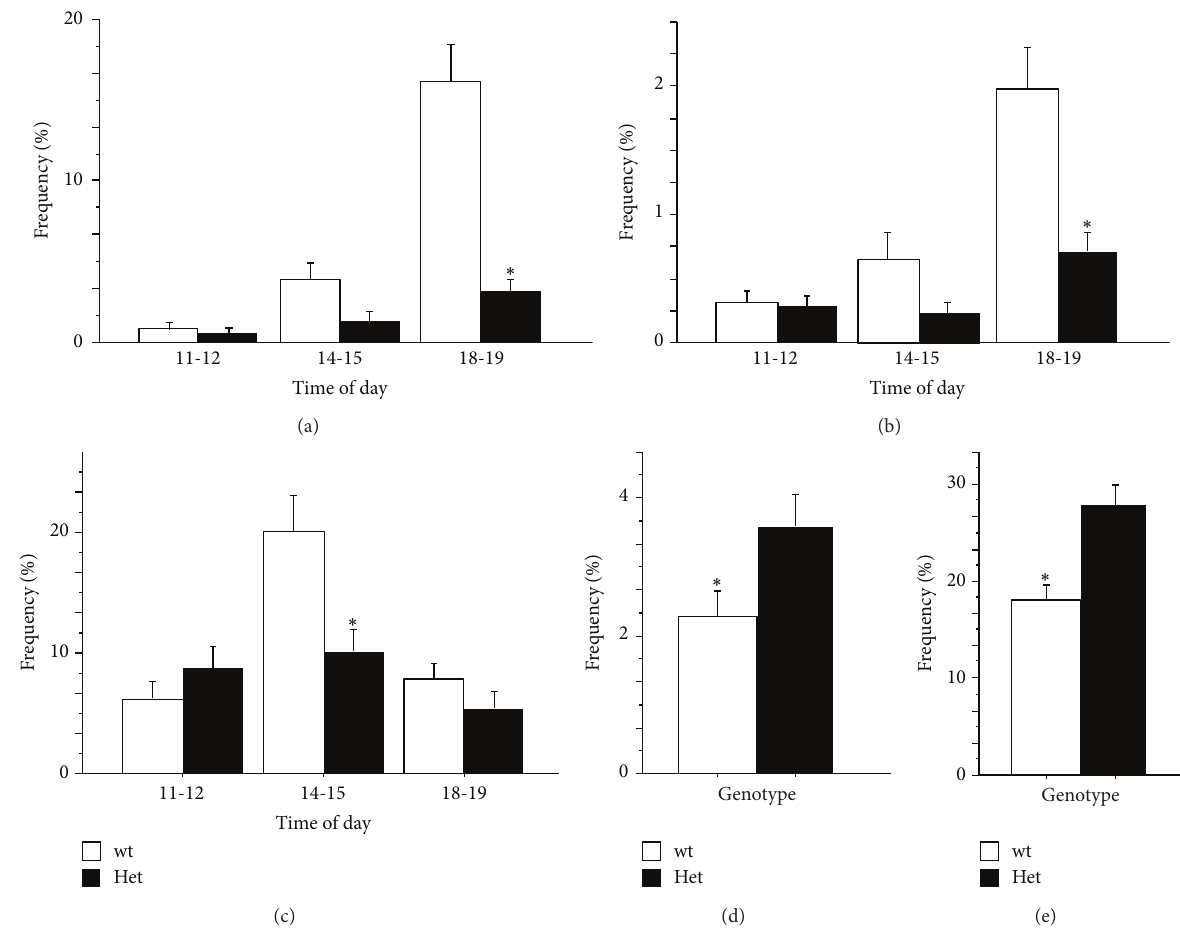
Figure 3: Spontaneous behavioural profile in the home-cages. The analysis of spontaneous behaviour in the home-cages revealed that MeCP2- 308 heterozygous female mice (Het) show decreased cage-directed exploratory behaviours in the home-cages compared to wild-type controls (wt). Burrowing (a) and digging (b) and bar holding episodes (c) were significantly less frequent in Het mice. Het mice spent more time drinking (d) and eating (e) compared to wt. The spontaneous behaviour in home-cages of individually housed mice was scored 3 times per day (11.00-12.00; 14.00-15.00; 18.00-19-00; highlighted by dashed lines in Figure 2). Each session consisted of 15 observations. The profile of daily activity was obtained by averaging 3 consecutive days of data collection. Data are expressed as % frequency ± SEM. ∗ 𝑃 < 0.05